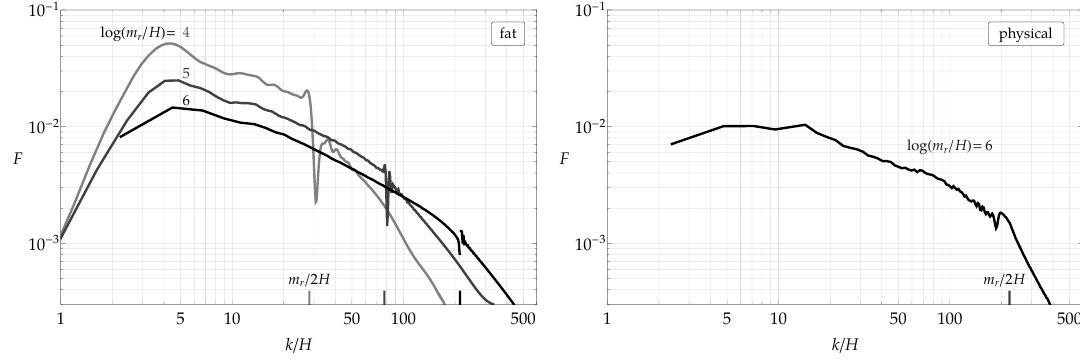
Figure 11 . The shape of the spectrum of axions emitted instantaneously by the string network F ( k=H; y ) for the fat string (left) and the physical (right) cases, for di(cid:11)erent scale separations, i.e. di(cid:11)erent values of y = m r =H